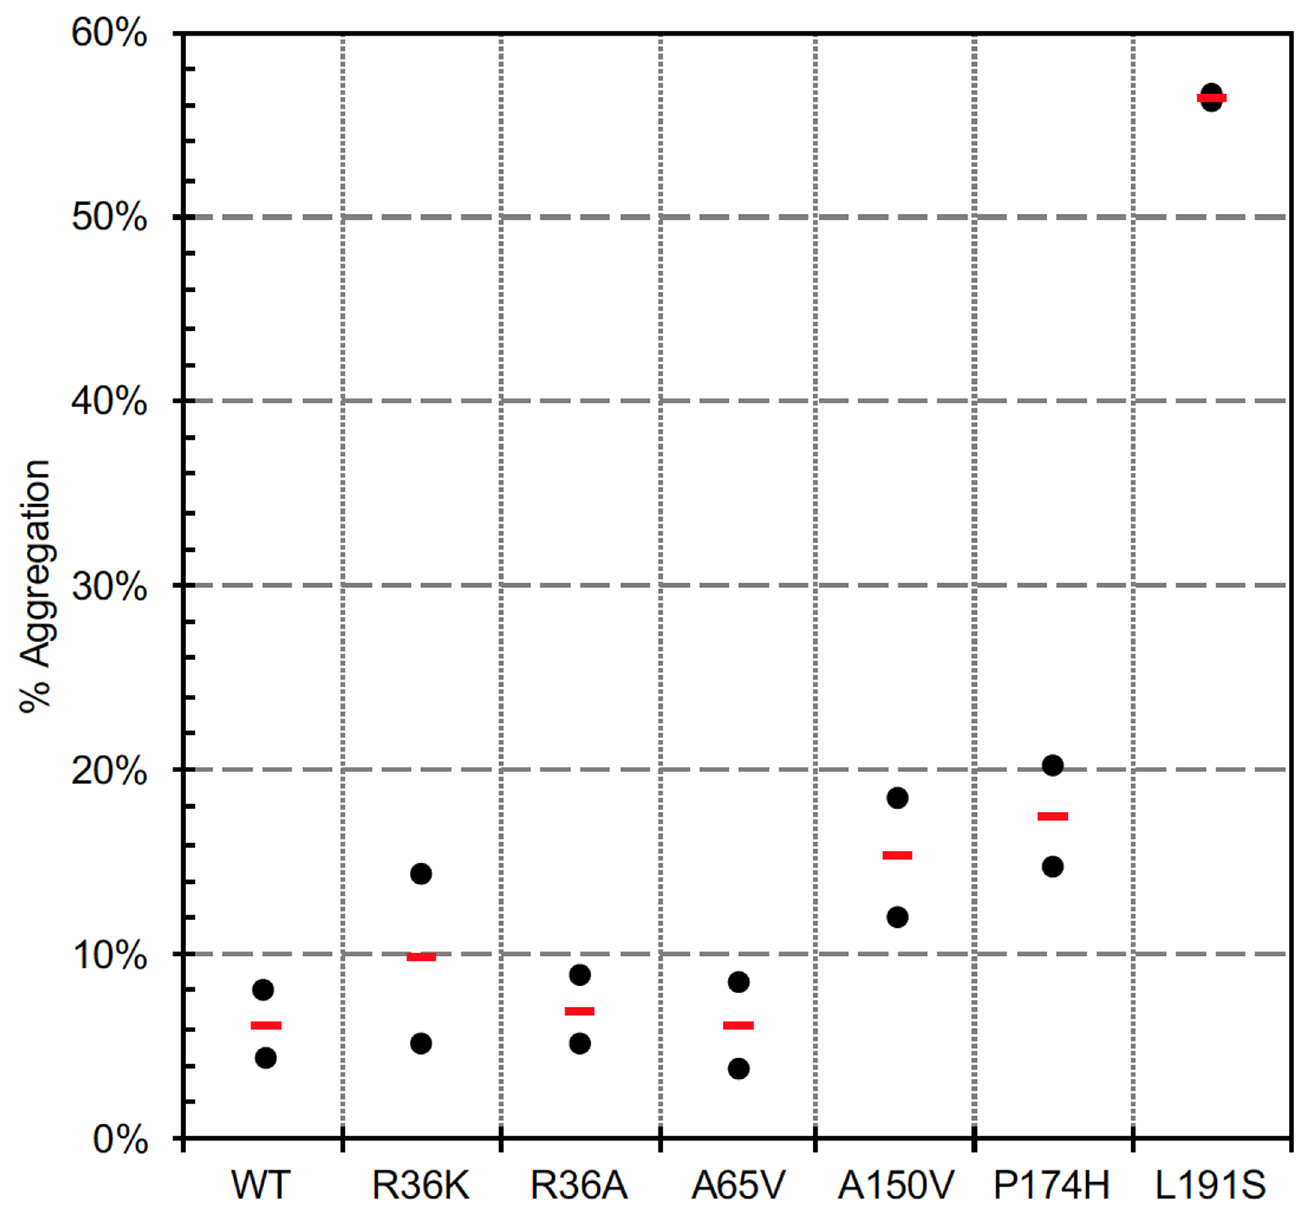
Fig 2. Assessment of variant aggregation. Photos of two stained gels, like that in Fig 1, were analyzed in ImageJ using the lane-plotting function with background subtraction. For each lane, we measured the total peak area in the 30–80 kDa range (P50.80), and the PIMT peak area at 30 kDa (P30). Percent aggregation was then calculated as P50.80/(P50.80 + P30). Data for individual gels is shown with black symbols, and averages with red